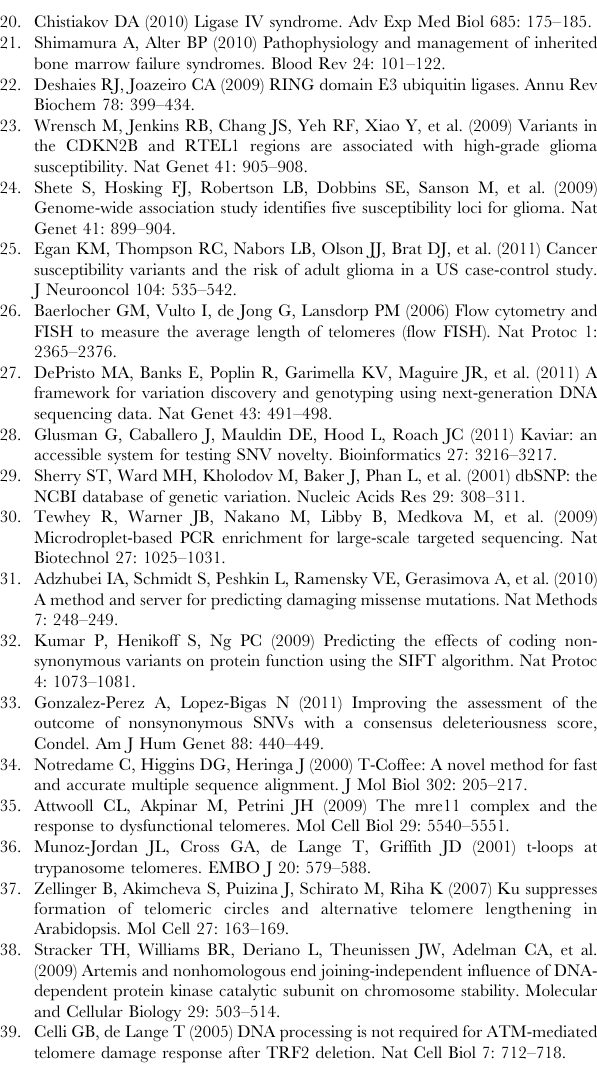
Table S4 Primers for RTEL1 locus used in IonTorrent